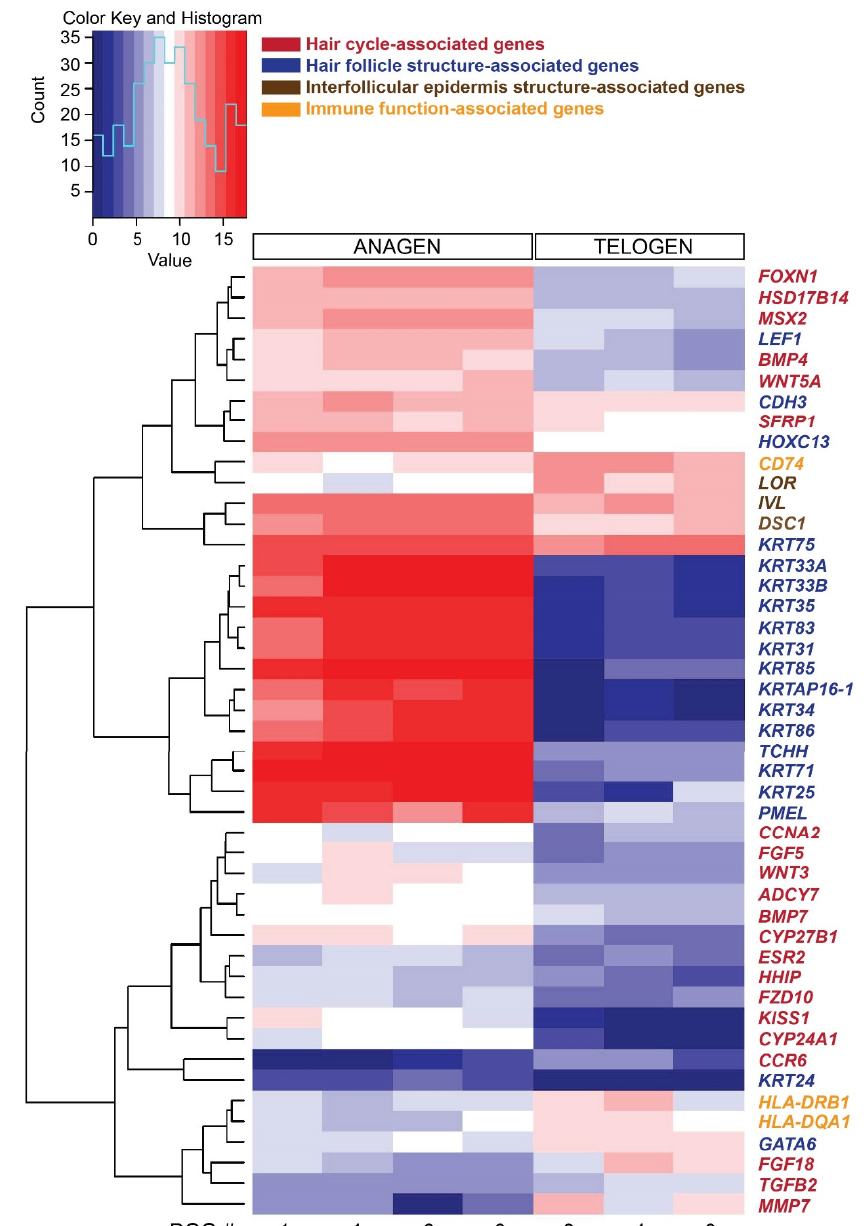
Figure 3. Heat map presenting hierarchical clustering of a preselected subset of 46 genes, based on their known function associated with hair cycle, hair follicle structure and function and stem cells, comparing late anagen and telogen hair cycle stages. High expression is shown in red, low expression in blue, intermediate DESeq2 normalized values in white and different shades of red and blue.